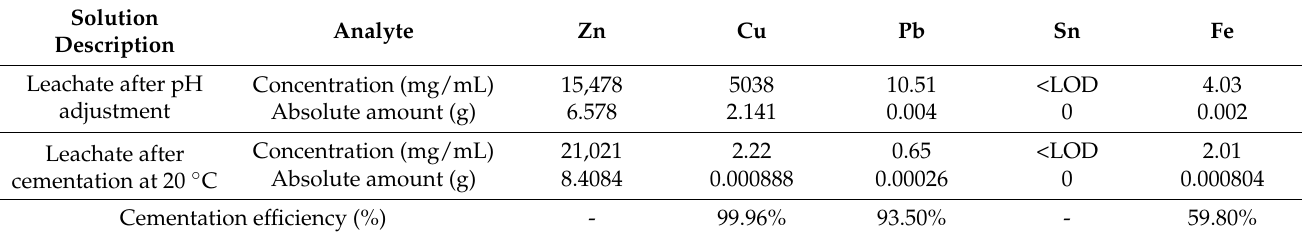
Table 7. Chemical analysis of solution before and after cementation.